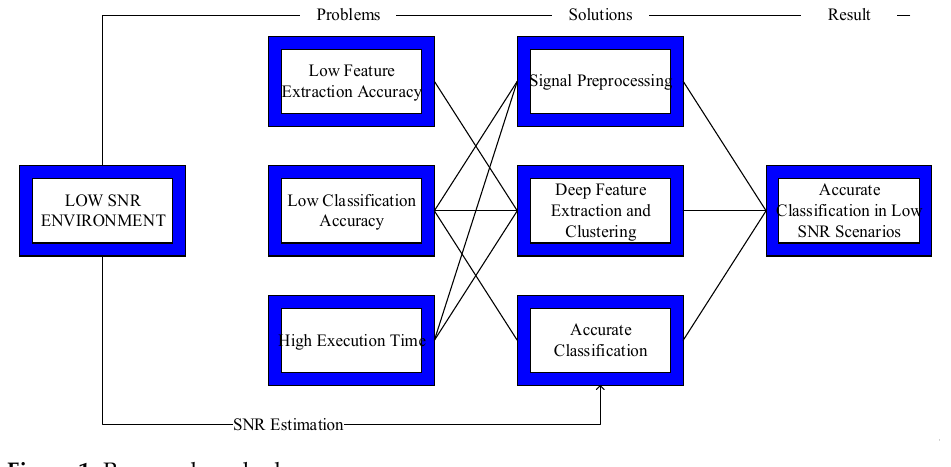
Figure 1. Proposed work plan